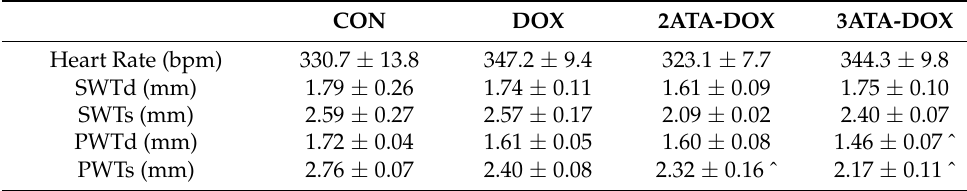
Table 1. Cardiac Function.